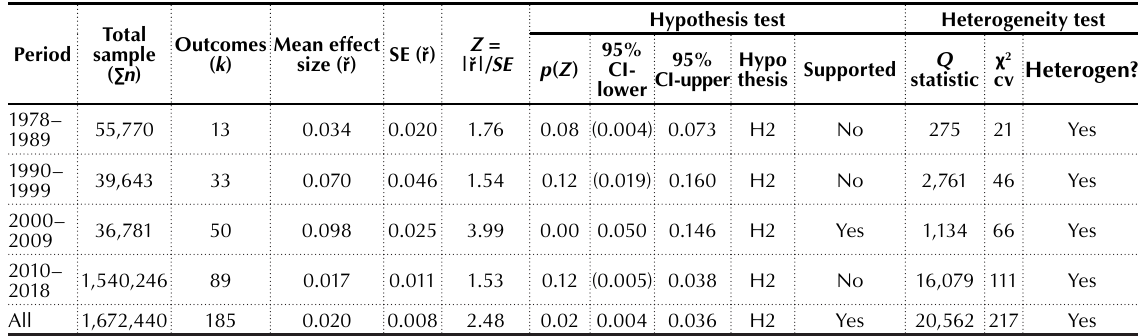
Source: Authors’ calculation.